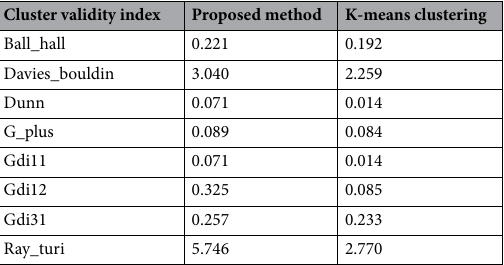
Table 3. Comparison of various cluster validity indices between our proposed method and k-means clustering for DS vs control. Higher value signifies better than the other value in the same row (cluster validity index).